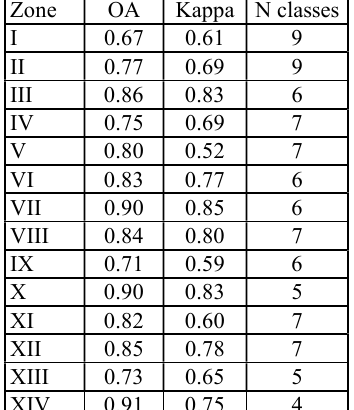
Table 3. Overall accuracies (OA), Kappa coefficient and number of classes (N classes) obtained for each zone.